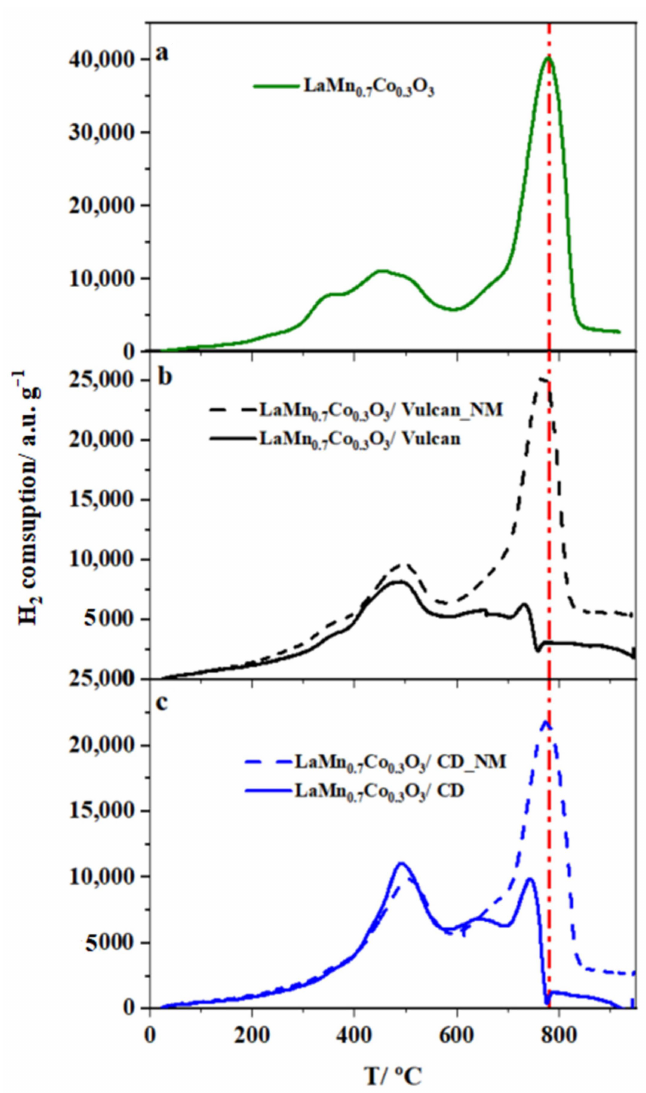
Figure 11. Temperature Programmed Reduction (TPR) profiles for the di ff erent mixtures prepared with a 1:1 mass ratio with (solid line) or without (dashed line) the agate mortar. ( a ) LaMn 0.7 Co 0.3 O 3 perovskite, ( b ) LaMn 0.7 Co 0.3 O 3 / Vulcan mixtures, and ( c ) LaMn 0.7 Co 0.3 O 3 / CD